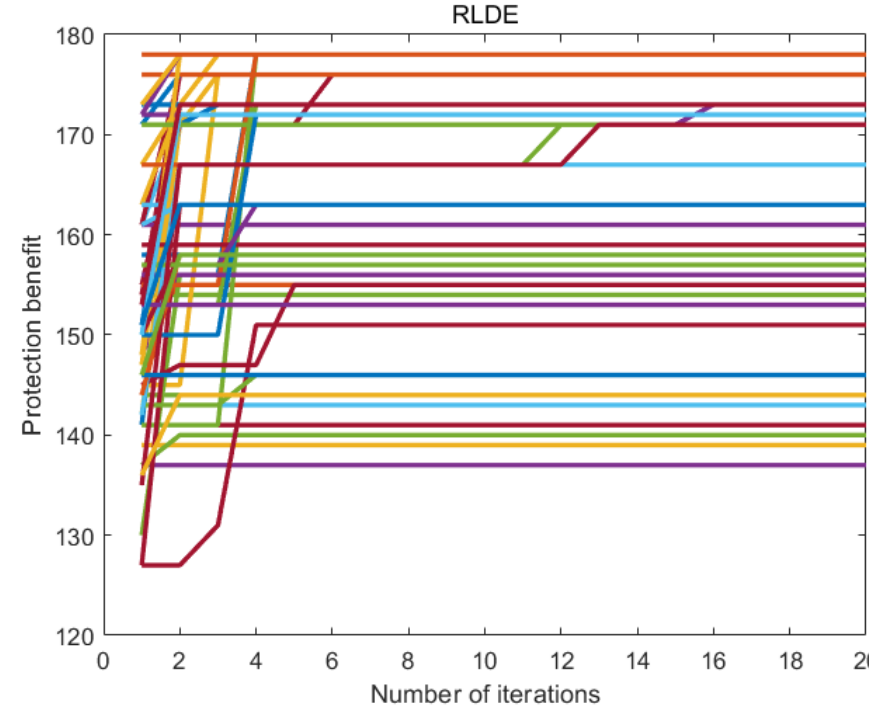
Figure 8. Population size is 15, and the RLDE algorithm is run 100